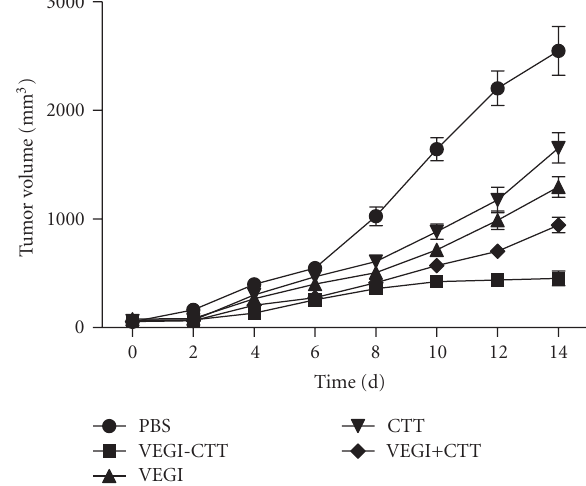
Figure 8: E ff ect of chimeric protein VEGI-CTT in treating CA46 human lymphoma xenograft-bearing nude mice. Nude mice were inoculated with CA46 human lymphoma cells, and the treatment started upon tumor xenograft establishment in nude mice. Tumor xenograft-bearing nude mice were injected with indicated doses of VEGI-CTT, VEGI, CTT, or VEGI and CTT combined treatment for two weeks, and tumor volumes were measured on alternate days. Mean values and standard deviations are presented as tumor volumes in each group ( n = 9). The experiments were repeated with similar